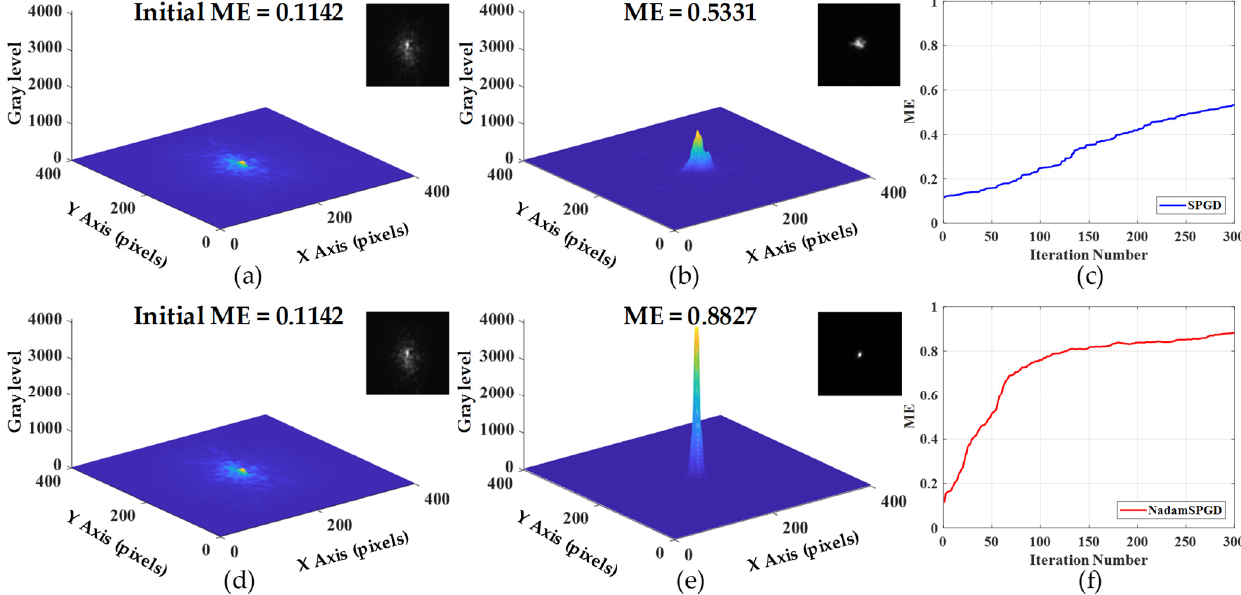
Figure 11. Comparison of correction results using SPGD and NadamSPGD on the SLAO experiment platform: ( a ) initial far-field image before correction; ( b ) SPGD correction result after 300 iterations; ( c ) SPGD residual wavefront ME as a function of iterations; ( d ) initial far-field image before correction; ( e ) NadamSPGD correction result after 300 iterations; ( f ) NadamSPGD residual wavefront ME as a function of iterations.